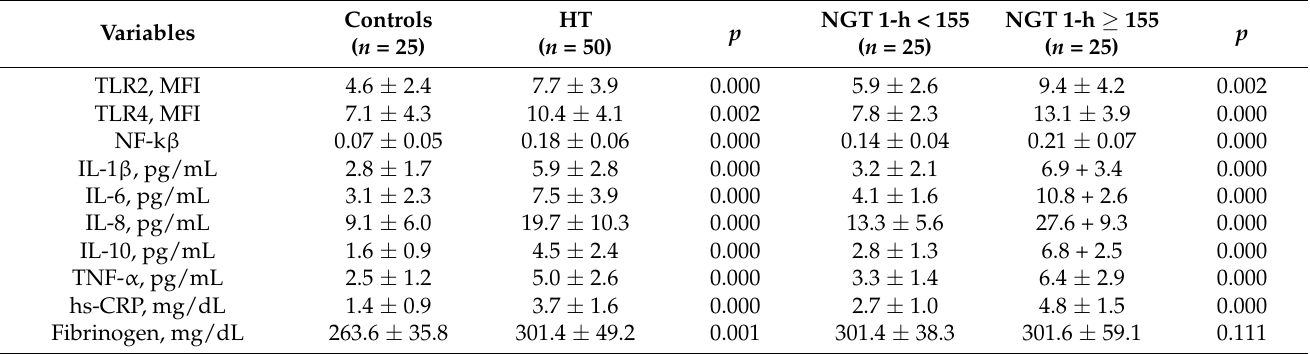
Table 2. Inflammatory parameters of the whole study population and of the two groups of hyperten- sive patients stratified by 1-h post-load plasma glucose.